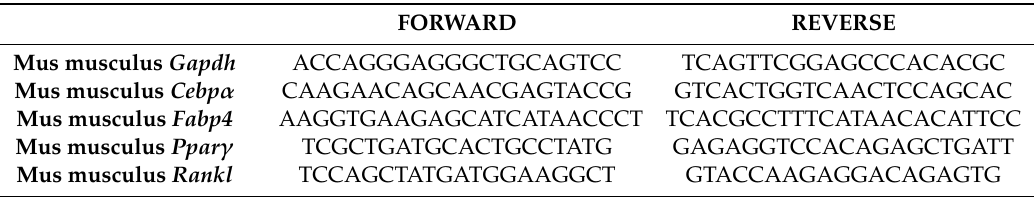
Table 1. Real-Time PCR Primer